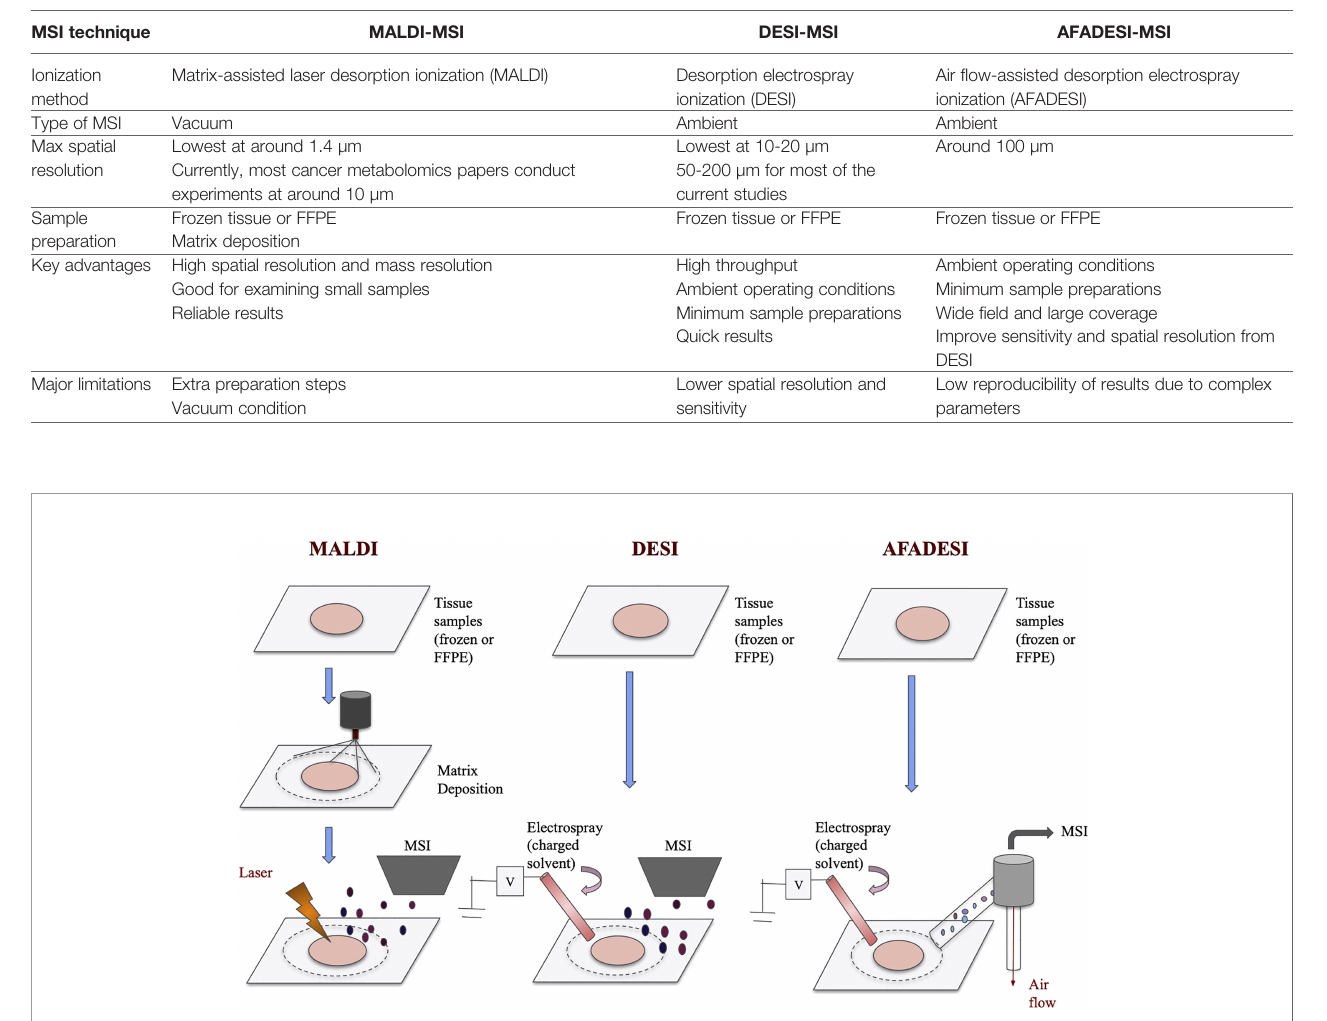
FIGURE 1 | Schematics of MALDI, DESI, and AFADESI. Overview of MALDI, DESI, and AFADESI processes prior to MSI. All three techniques accept frozen or FFPE tissues, and MALDI requires an additional matrix deposition step. Subsequently, MALDI technique uses a laser to ionize the sample before MS detection whereas DESI and AFADESI use high pressure solvent to directly ionize the sample. Additionally, AFADESI depends on air fl ow to carry the ions over long distances to be detected.